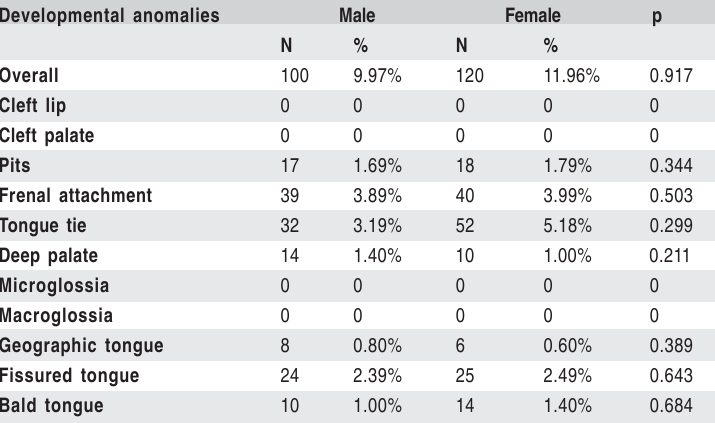
Table 3 - Developmental variation of oral mucous